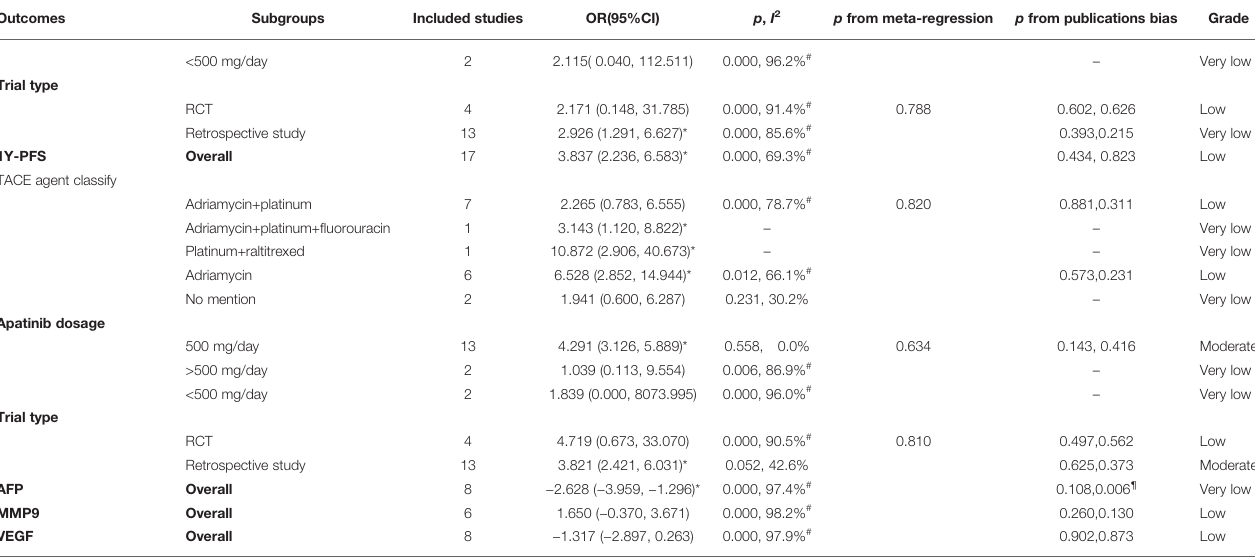
p , I 2 p frommeta-regression OR (95%CI) from network OR(95%CI) from RCTs pairwise meta-analysis meta-analysis